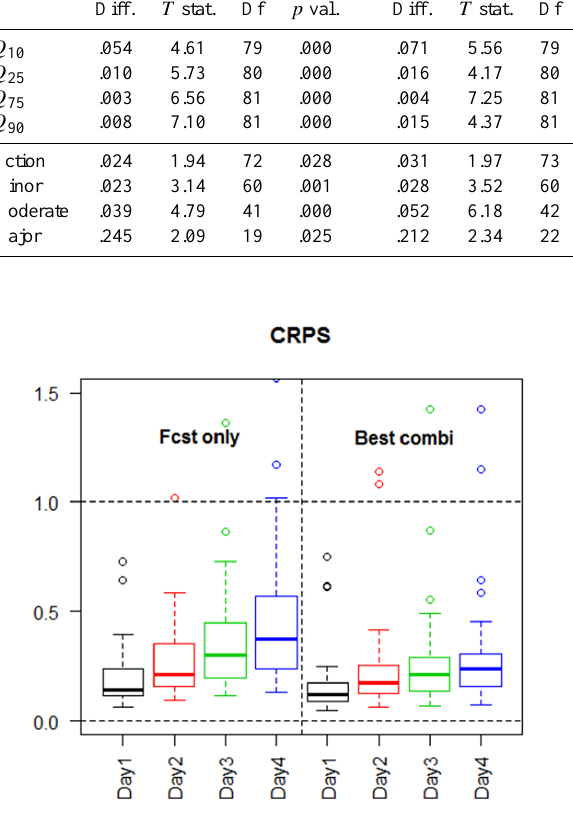
Figure 16. CRPS for the forecast-only configuration and for the best-performing joint predictor at each gauge for different lead times and event thresholds. The CRPS’ perfect score equals zero.